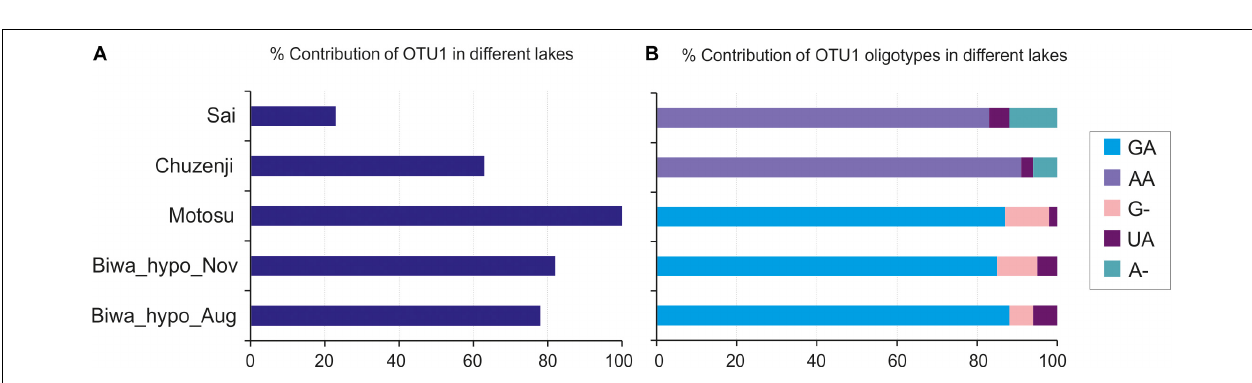
FIGURE 7 | Oligotyping of the dominant kinetoplastid OTU (OTU_1). (A) Percentage contribution of OTU_1 in the hypolimnion of studied lakes; (B) Percentage contribution of OTU_1 oligotypes. GA, AA, G-, UA and A- represent the detected oligotypes.